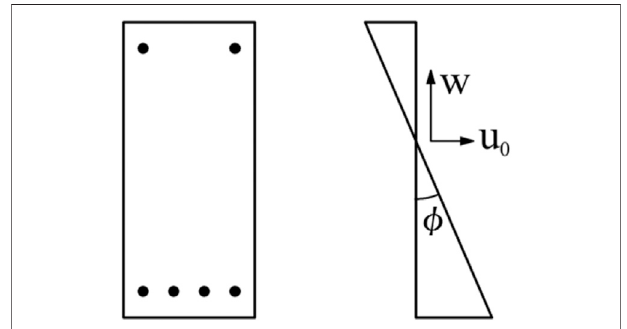
FIGURE 1 | Kinematics of the transverse section of the concrete beam reinforced with FRP